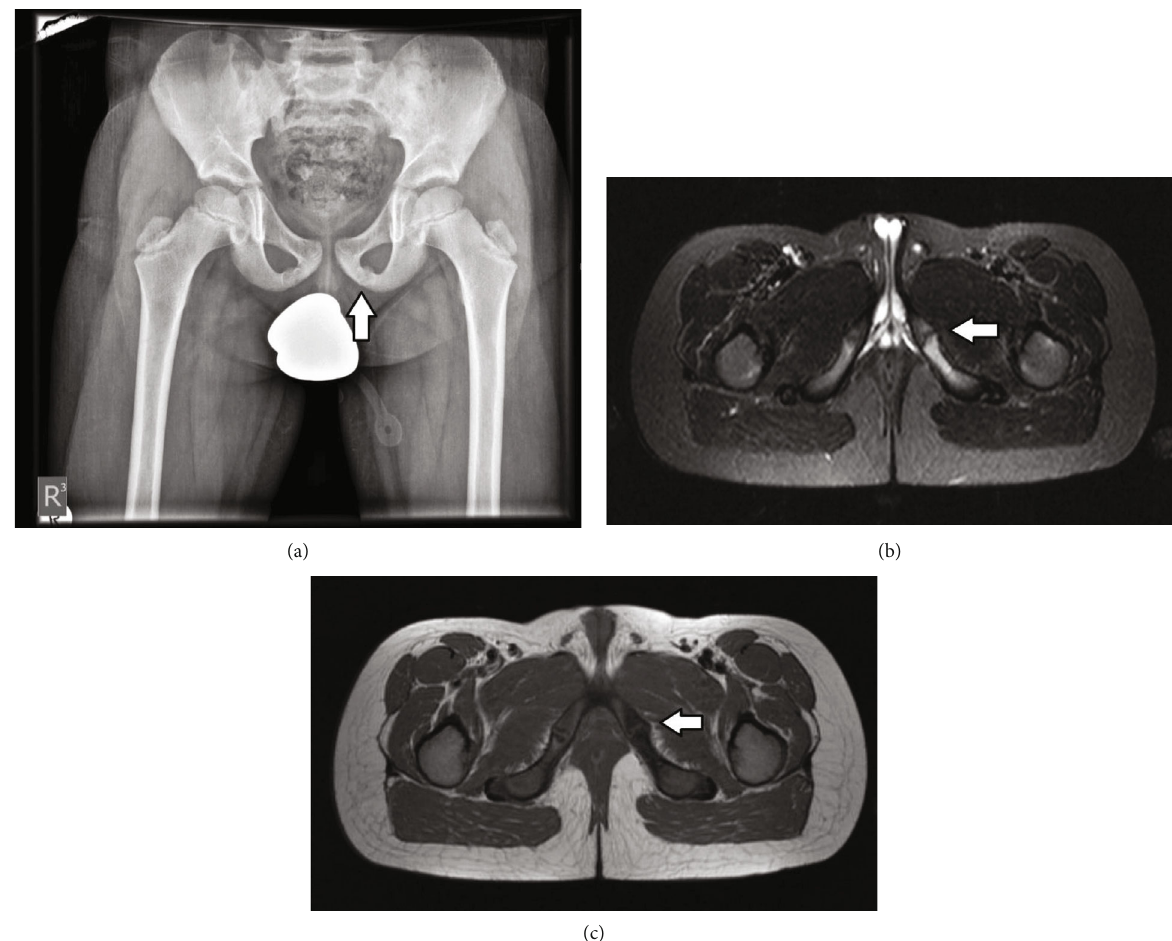
Figure 3: (a) Asymmetric enlargement of the left ischiopubic synchondrosis. (b and c) STIR (b) and T1W (c) sequences in transverse plane in an adolescent with left gluteal pain, demonstrate irregularity of the left ischiopubic synchondrosis, with bone marrow edema involving the bony structures around the synchondrosis. The adjacent soft tissues maintain their normal MRI